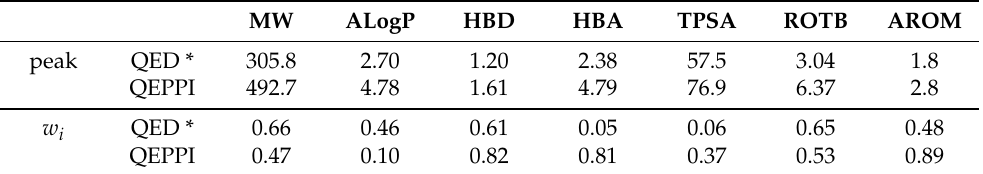
Figure 1. Histograms of seven molecular physicochemical properties for a set of non-redundant compounds of iPPI-DB. Molecular weight (MW) ( a ), LogP value estimated by Ghose-Crippen method (ALogP) ( b ), number of hydrogen bond donors (HBD) ( c ), number of hydrogen bond acceptors (HBA) ( d ), topological molecular polar surface area (TPSA) ( e ), number of rotatable bonds (ROTB) ( f ), and number of aromatic rings (AROM) ( g ). The solid red lines describe the asymmetric double sigmoid (ADS) function (1) used to model the QEPPI histograms. The black dashed lines describe the ADS function used to model the quantitative estimate of drug-likeness (QED) histograms. Table 1. Distribution peaks and optimized desirability function weightings of each molecular physicochemical